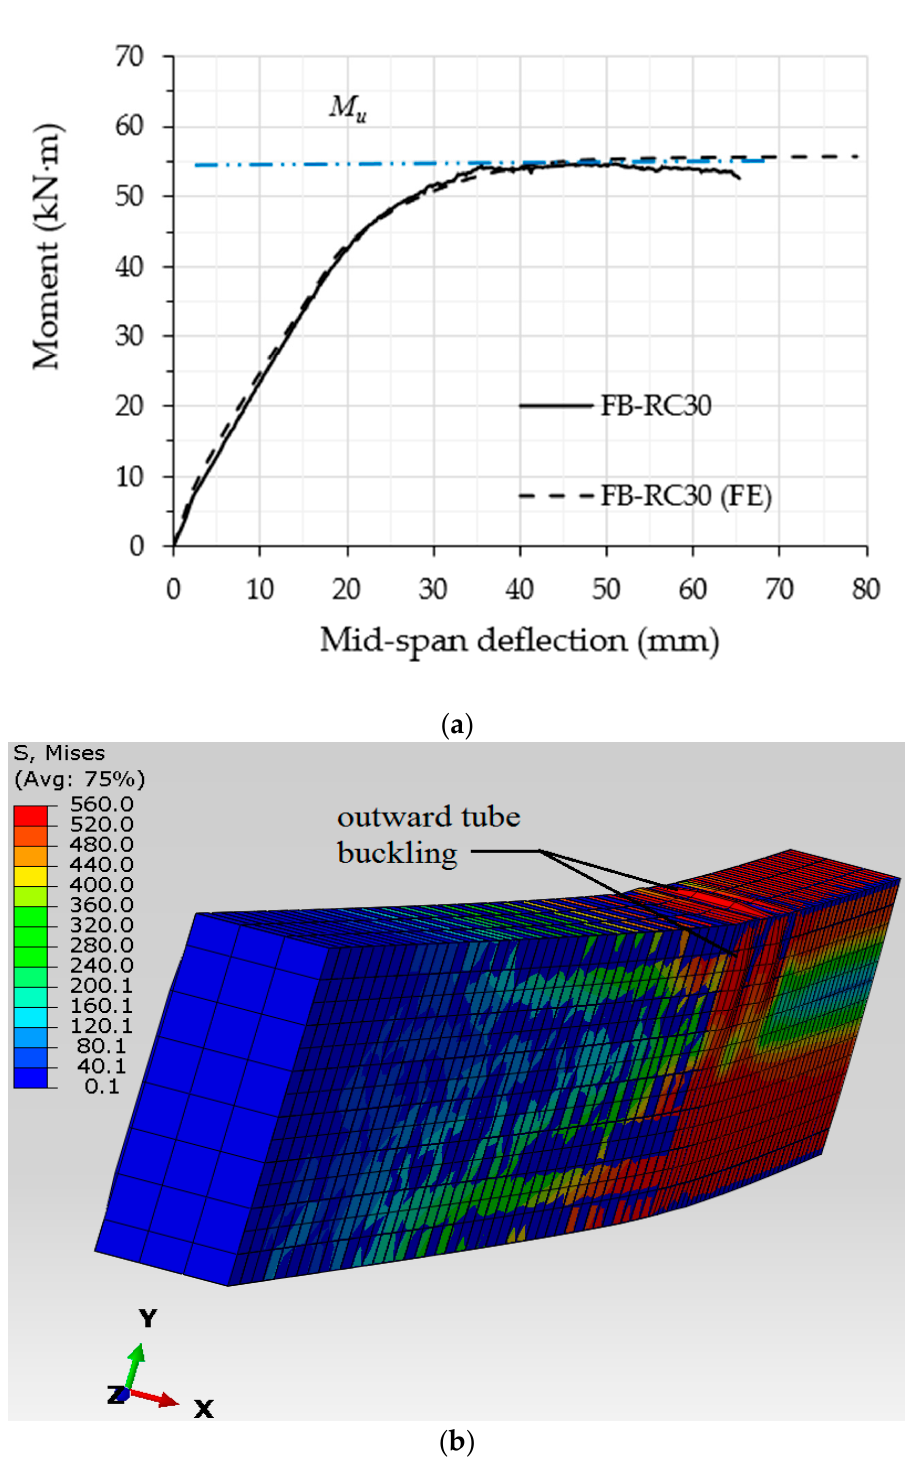
Figure 9. Verification of the FB-RC30 FE model with the corresponding tested specimen: ( a ) flexural behavior; ( b ) numerical failure mode.